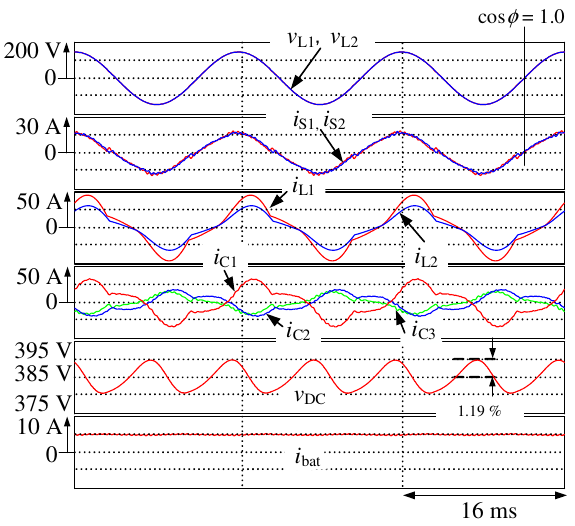
Figure 8. Simulation results for Figure 4 during battery-discharging operation.